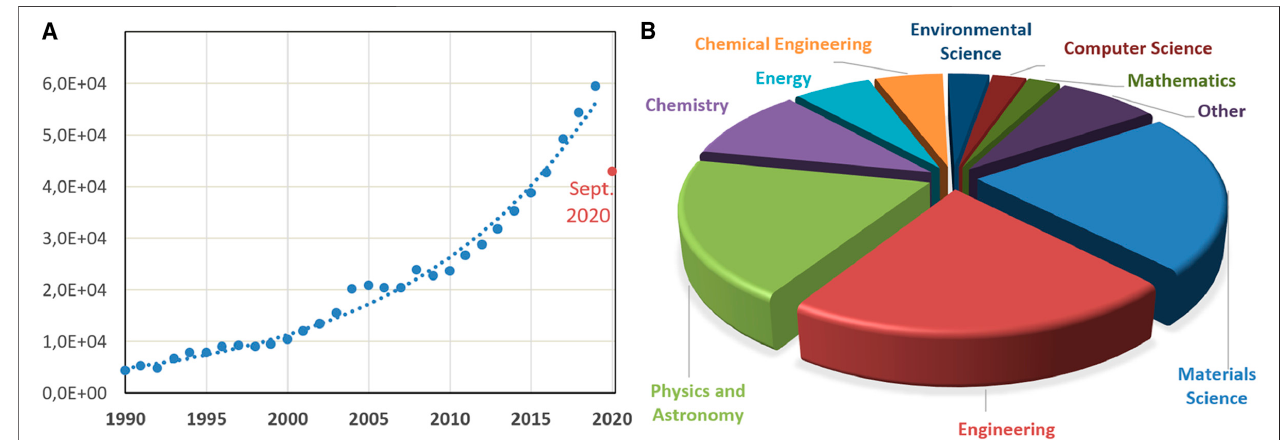
FIGURE 1 | Number of documents (keywords: Energy AND Materials, source: Scopus) published in the last 30 years (A) ; Subject areas of scienti fi c contributions dedicated to energy materials (B) .